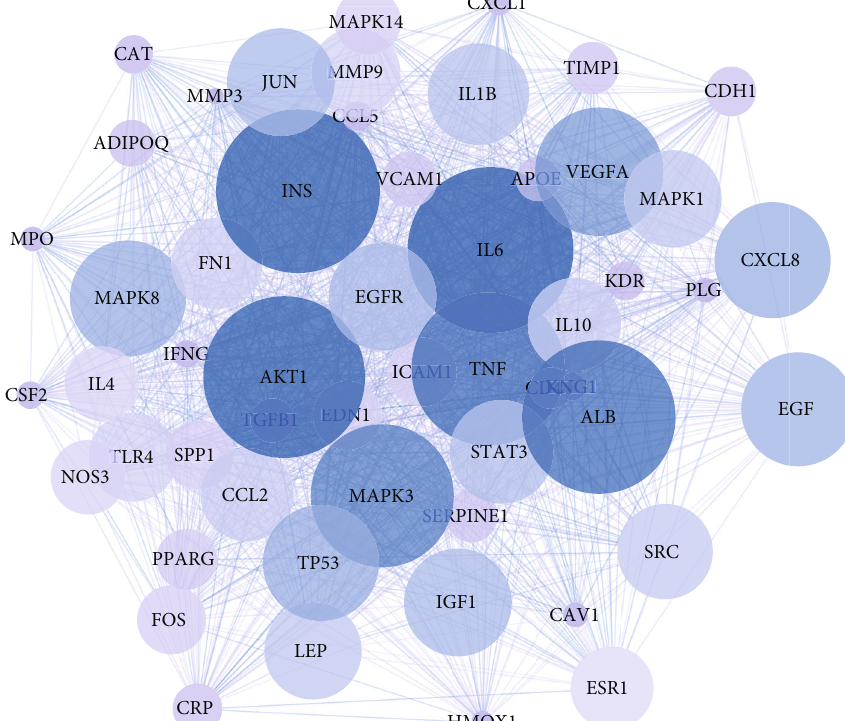
Figure 4: The PPI network